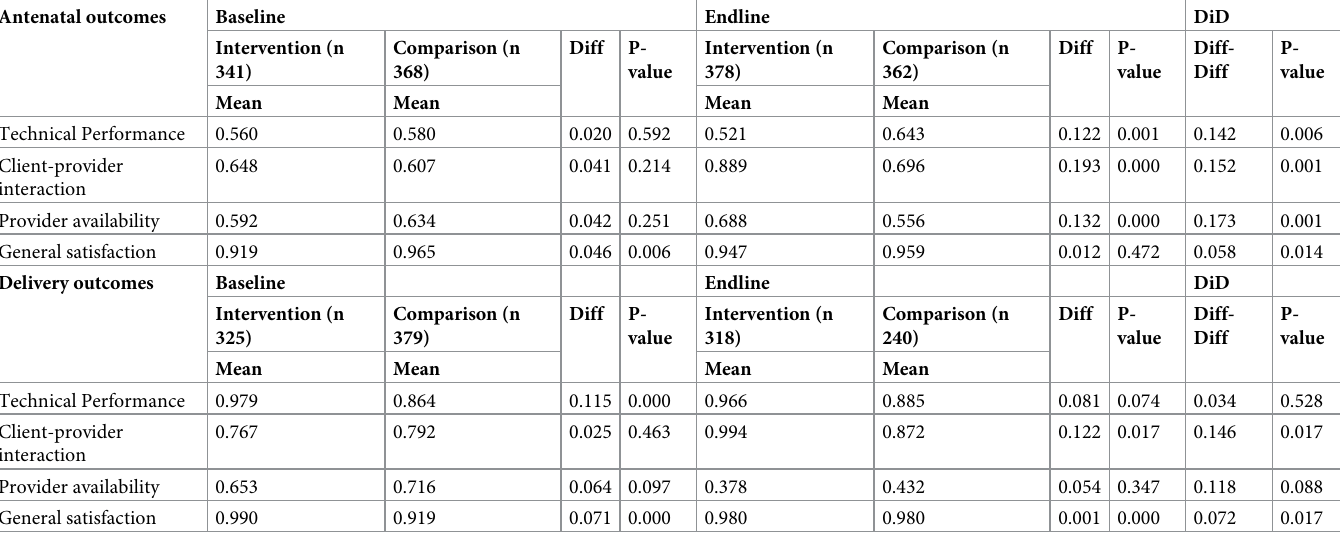
Table 2. Multivariable logistic regression of antenatal and delivery client satisfaction with services, comparing intervention to comparison at baseline and endline. Antenatal